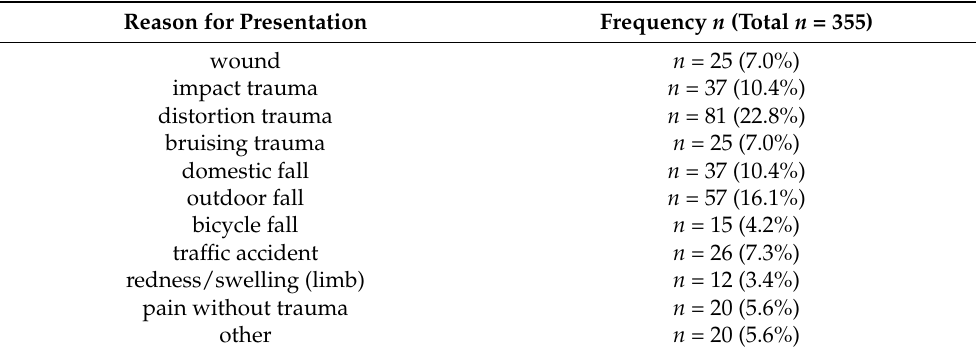
Table 1. Reason for presentation of the comparison group.